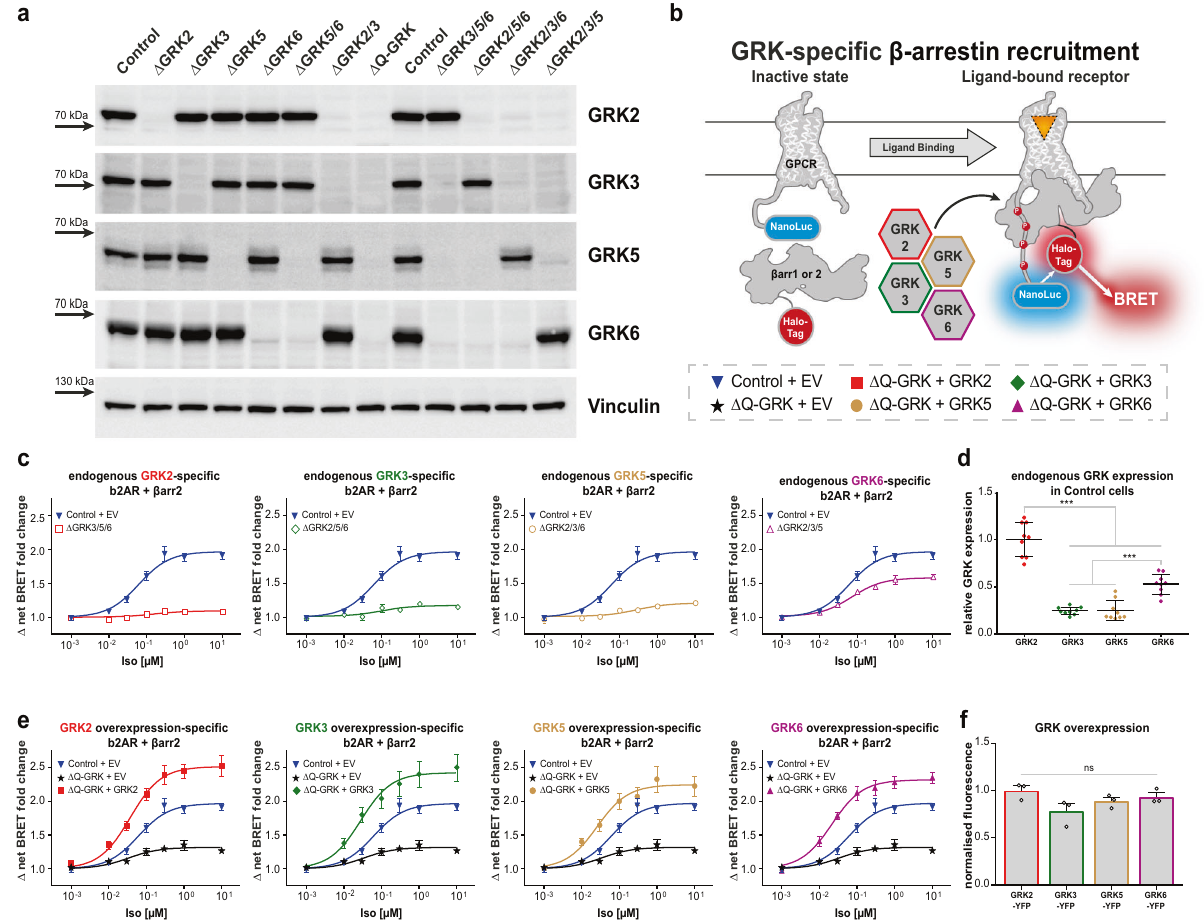
Fig. 1 GRK knockout cells enable the characterisation of GRK-speci fi c β -arrestin recruitment. a Single ( Δ GRK2, 3, 5 and 6), double ( Δ GRK2/3 or 5/6), triple ( Δ GRK3/5/6, 2/5/6, 2/3/6 and 2/3/5) and quadruple ( Δ Q-GRK) GRK knockout cells were generated using the CRISPR/Cas9 technology and established as single-cell clones. The absence of GRK2, 3, 5 or 6 was con fi rmed by Western blot analysis. A representative blot of n = 4 independent experiments is shown (for quanti fi cation, see Supplementary Fig. 1d). b Schematic depiction of the performed NanoBRET β -arrestin ( β arr) recruitment assay and colour-coding for GRK-speci fi c conditions used throughout the paper. The Halo-Tag- β arr fusion protein is recruited to a NanoLuciferase (NanoLuc)-tagged GPCR upon agonist activation and subsequent receptor phosphorylation. The resulting change in proximity of the Halo-Tag and the NanoLuc increases measured BRET ratios, enabling the agonist concentration-dependent analysis of β arr recruitment. c Halo-Tag- β arr2 recruitment to the b2AR-NanoLuc upon stimulation with isoprenaline (Iso) in cells expressing all endogenous GRKs (Control + empty vector (EV)) or only one remaining endogenous GRK (triple knockout cells Δ GRK3/5/6, Δ GRK2/5/6, Δ GRK2/3/6 and Δ GRK2/3/5). d The relative GRK protein expression in Control cells determined by Western blot of n = 3 independent lysates as described in Reichel et al. 27 . Data are depicted as mean ± SEM of n = 3 independent blots. GRK expression levels were compared using ANOVA and two-sided Tukey ’ s test (* p < 0.05; ** p < 0.01; *** p < 0.001). e β arr2 recruitment to the b2AR in quadruple GRK knockout cells ( Δ Q-GRK), overexpressing a single GRK ( Δ Q-GRK + GRK) or expressing all endogenous GRKs (Control + EV). BRET data in ( c ) and ( e ) are presented as Δ net BRET fold change, mean of n = 3 independent experiments ± SEM. For better comparison, the Control and Δ Q-GRK curves are shown multiple times. f GRK – YFP fusion proteins were transfected in Δ Q-GRK and YFP fl uorescence was measured to con fi rm similar expression levels of all transfected GRKs. YFP fl uorescence was compared using ANOVA and two-sided Tukey ’ s test (ns not signi fi cant). Corresponding experiments, con fi rming the catalytic activity of GRK – YFP fusion constructs are shown in Supplementary Fig. 3a. Measured fl uorescence is depicted as a mean of n = 3 independent experiments + SEM as normalised fl uorescence. All exact p values, test statistics, effect sizes, con fi dence intervals and degrees of freedom are provided in the Source Data fi